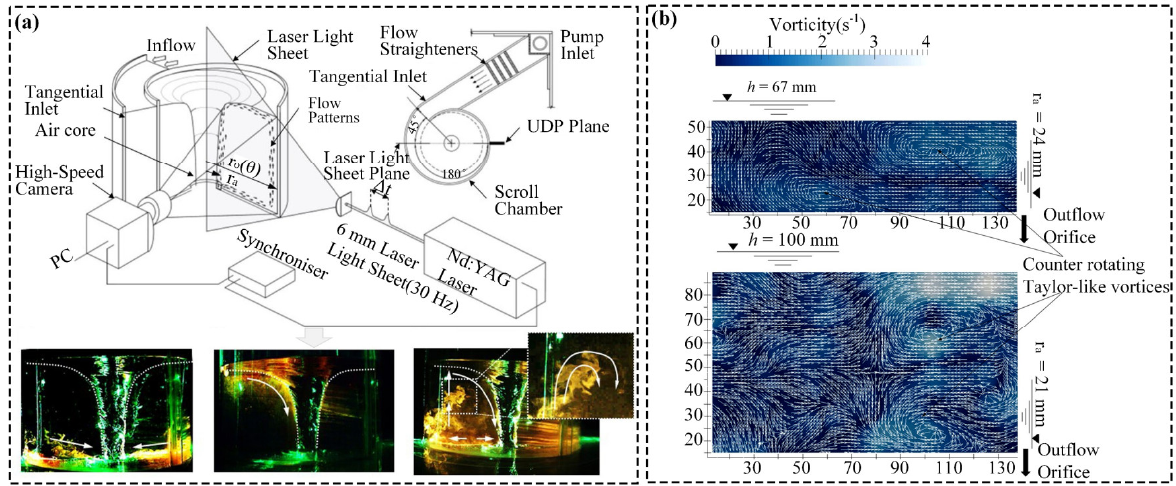
Figure 15. Observation of the Taylor–Couette vortex system. ( a ) Planar laser-induced fluorescence technique. ( b ) Velocity vector fields. (Reprinted with permission from Ref. [116]. 2018, Springer Nature).